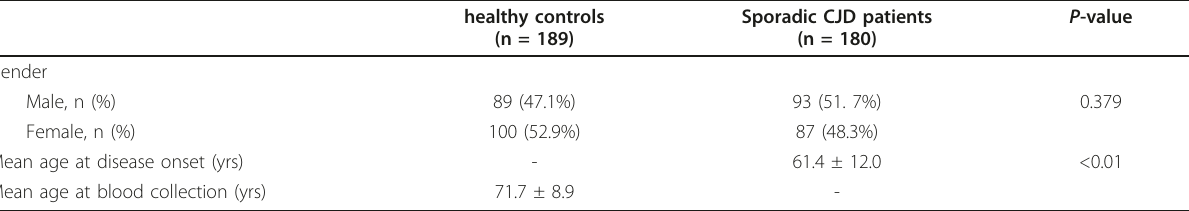
Table 1 General characteristics of healthy controls and sporadic CJD patients